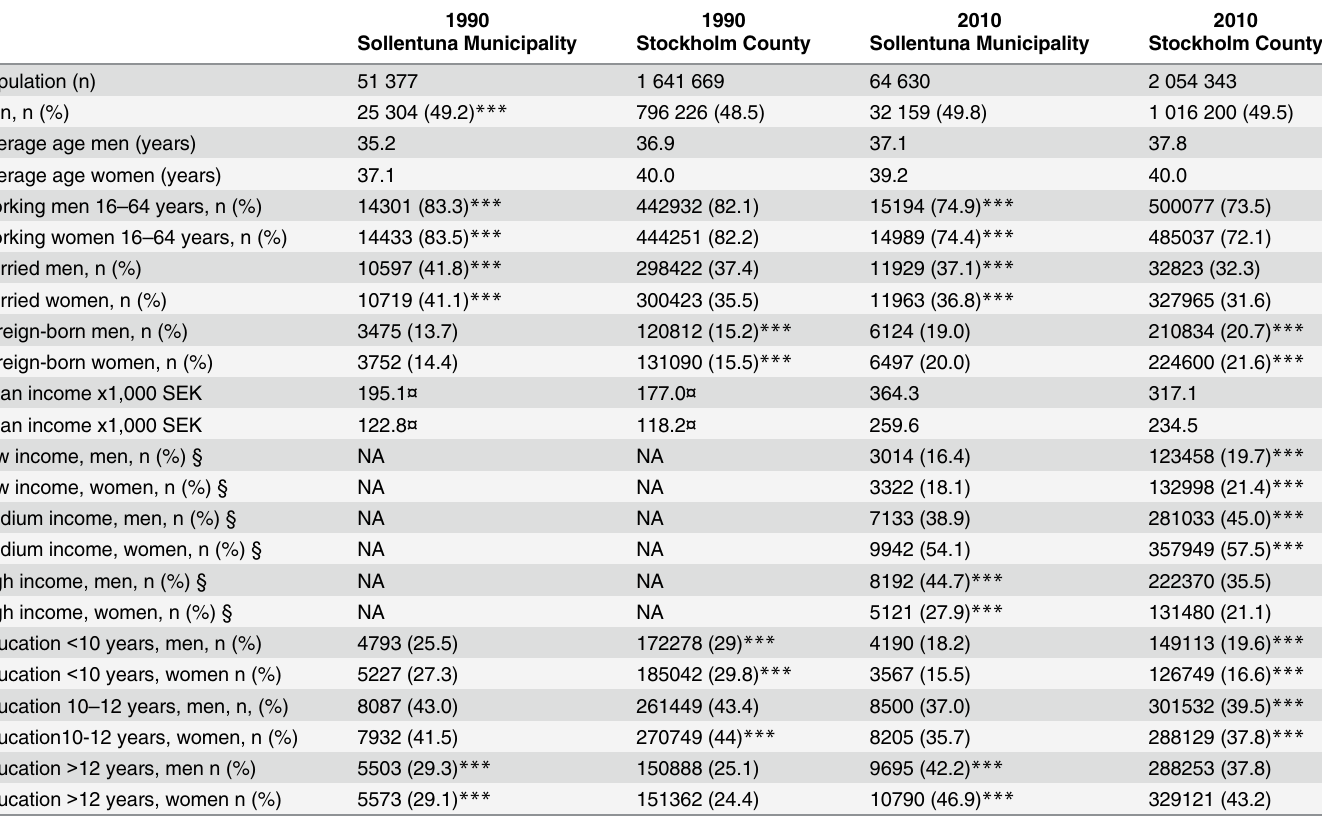
Table 1. Characteristics of the population who lived in Sollentuna, and Stockholm in 1990 and 2010.